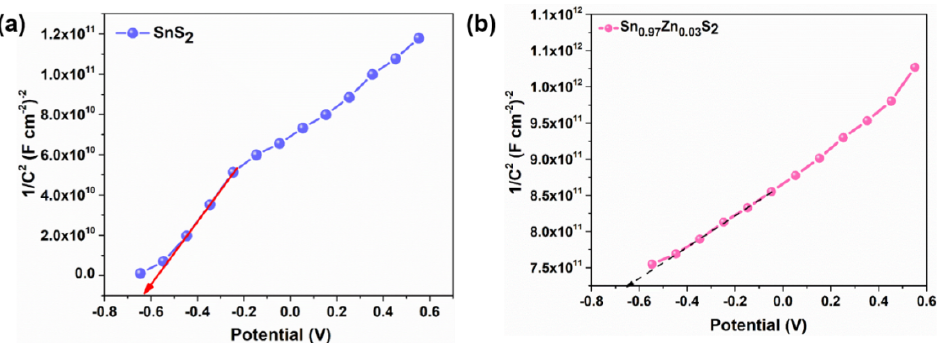
Figure 7. Mott–Schottky plots of ( a ) SnS 2 and ( b ) Sn 0.97 Zn 0.03 S 2 nanoflakes.